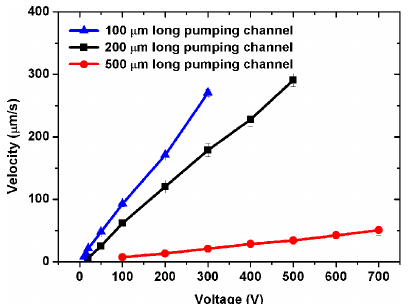
Figure 4. Experimental results of pumping velocity as a function of driving voltage with different pumping channel length in a five-stage pump. The PDMS gap is 20 µ m. The pumping and connecting channels are 20 µ m wide. The connecting channels are 1.4 times as long as the pumping channels. The inlet and outlet channels are 2 mm long, 40 µ m wide. All channels are 20 µ m high.